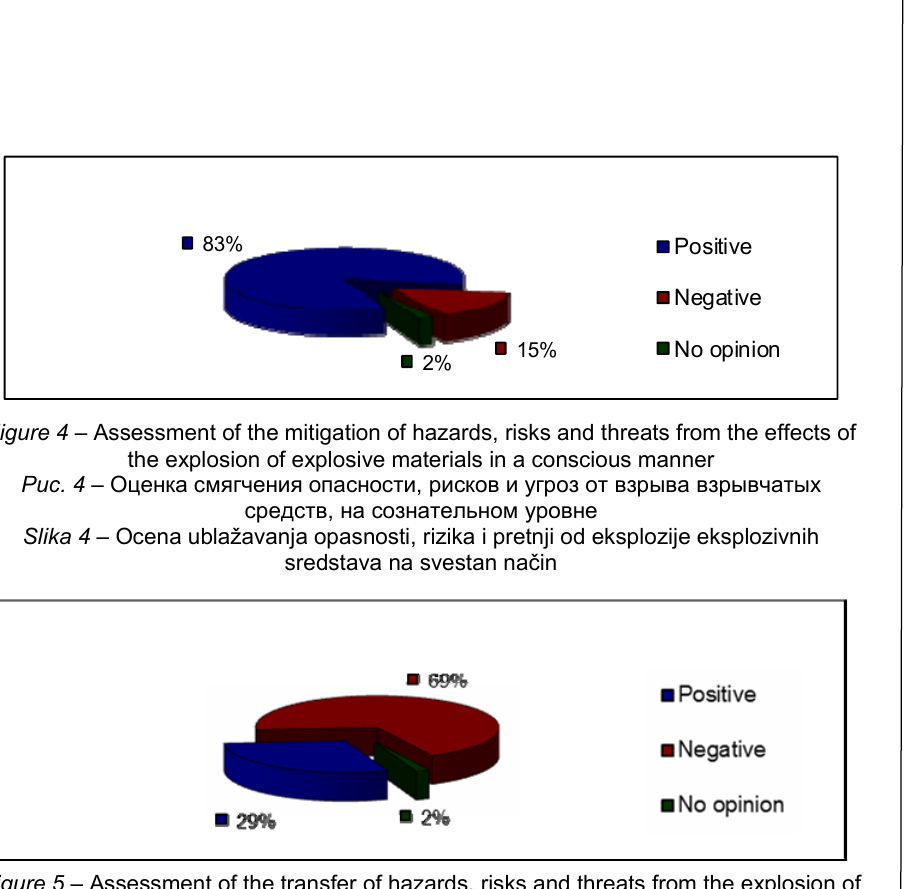
Figure 5 – Assessment of the transfer of hazards, risks and threats from the explosion of explosive materials to another party Рис . 5 – Оценка переноса опасности , рисков и угроз от взрыва взрывчатых средствк